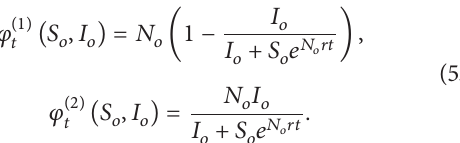
(𝑆 , 𝐼 ) = (0, 𝑆 + 𝐼 ) . 𝑜 𝑜 𝑜 𝑜 e Figure 4: Time evolution of the fuzzy projection ̂𝜑 𝑡 ( x 𝑜 ) on the axes 𝑆 and 𝐼 ,